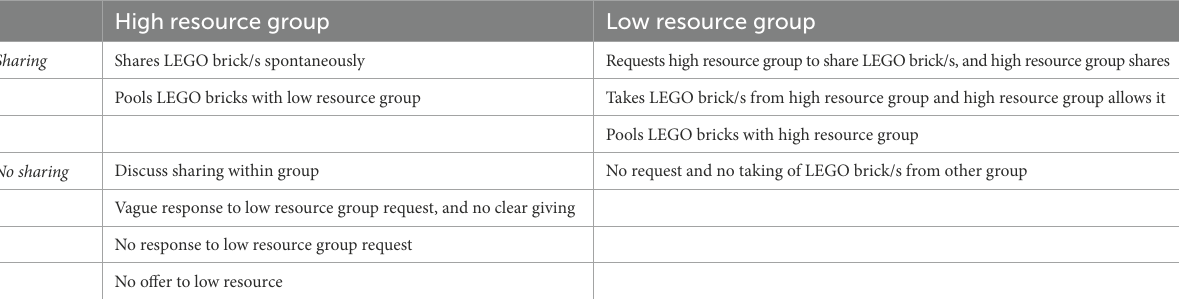
TABLE 1 Behaviors that were or were not considered as initiating sharing, by resource group for all